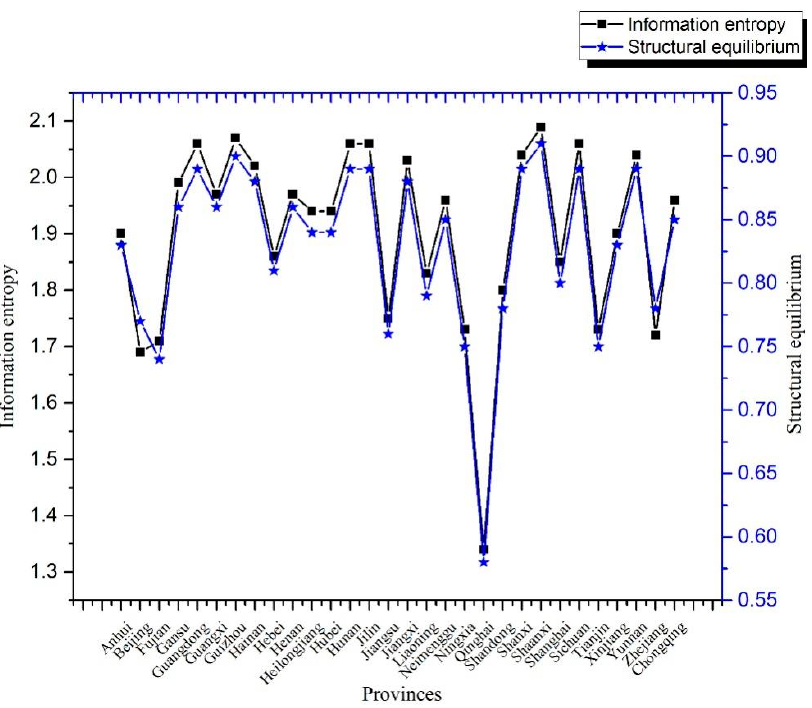
Figure 2. Information entropy and equilibrium degree of industrial land-use structure in various provinces of China.